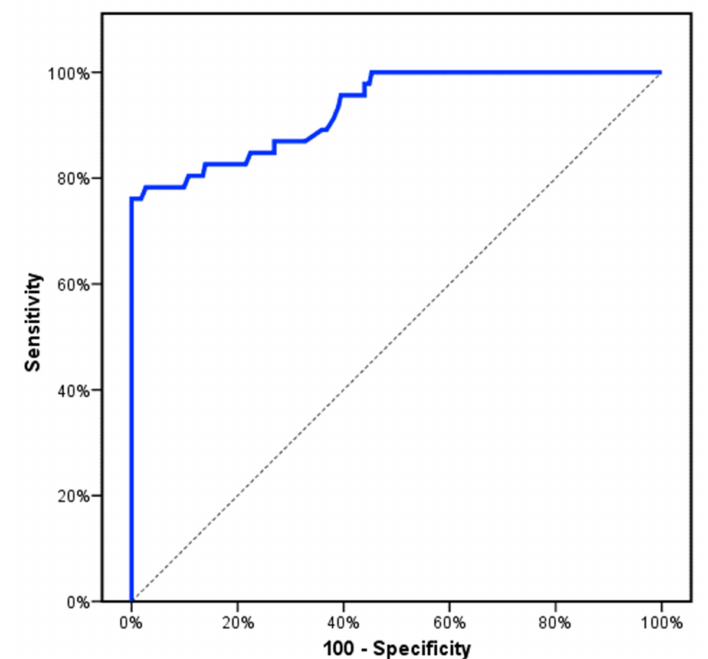
Figure 2. ROC curve for relative expression of CCL2 to discriminate MF patients (PMF and Post- PV/ET-MF) ( n = 46) from other subjects ( n =